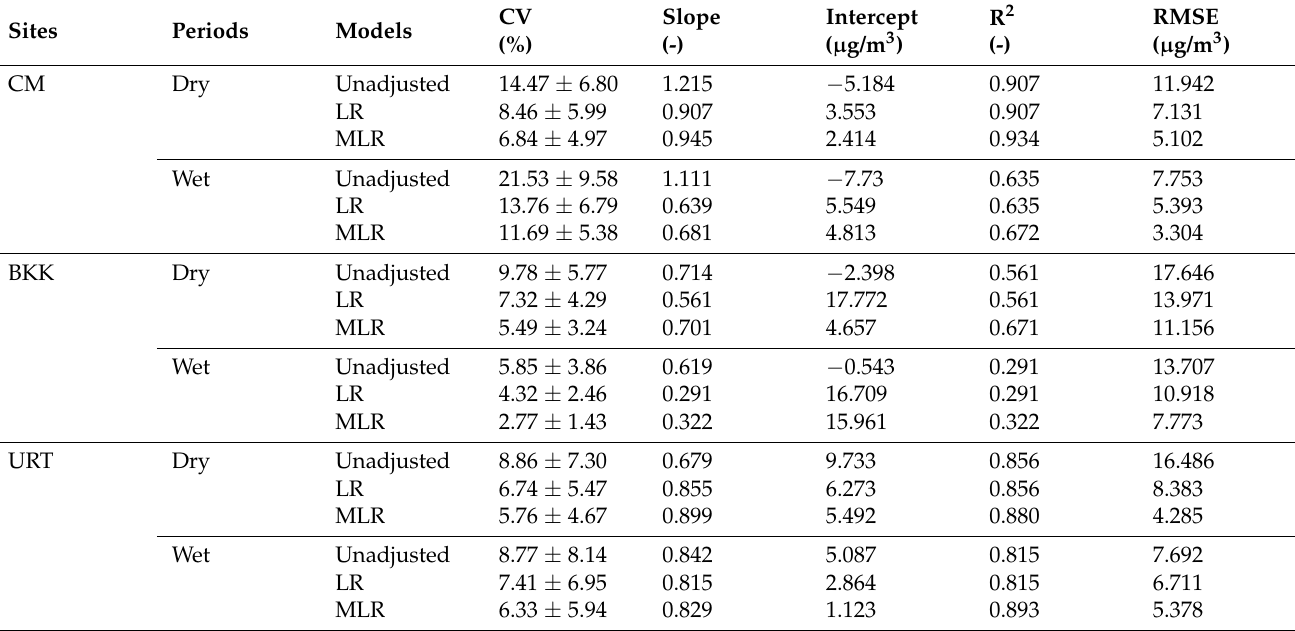
Table 4. Summary of performance metrics for hourly PM 2.5 concentrations for unadjusted LCS and adjusted LCS by LR and MLR calibration models at three